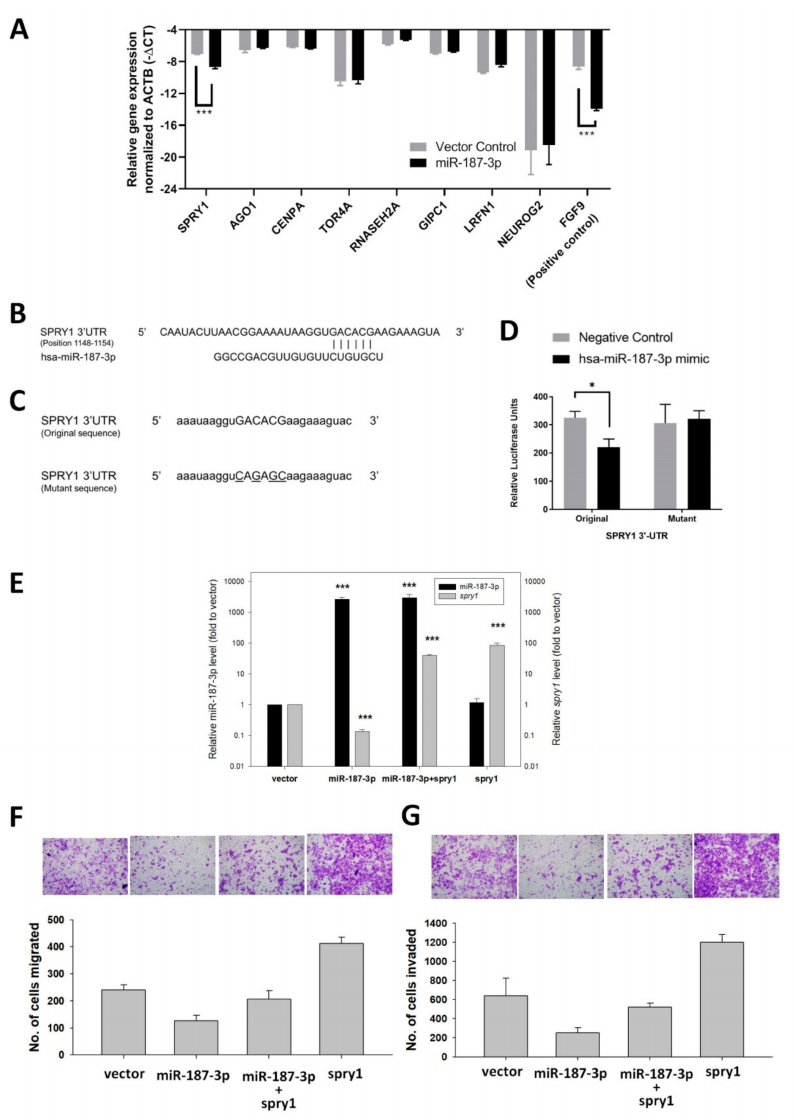
Figure 9. Identification of SPRY1 as a target gene of miR-187-3p in vitro: ( A ) Quantitative RT-PCR- based expression analysis of putative target genes within HCT116 stably transfected with miR-187-3p or the control vector. Expression of target genes was normalized to ACTB and reported as –delta Ct (negative delta Ct). FGF9 was used as a positive control. ( B ) Predicted binding site of miR-187-3p within the 3 (cid:48) -UTR region of the SPRY1 gene. ( C ) Design of SPRY1 (original and mutant) insert sequence within the reporter construct. Uppercase: potential binding site; underline: mutated bases within the potential binding site; lowercase: flanking 3 (cid:48) -UTR bases. ( D ) HCT116 cells were co-transfected with SPRY1 3 (cid:48) -UTR original or mutant sequence reporter constructs with has-miR- 187-3p mimic or negative control (empty vector) and Renilla luciferase control vector. The firefly luciferase signal for each transfectant was normalized by its corresponding Renilla luciferase signal and expressed in relative luciferase units. ( E ) Gene expression levels of miR-187-3p and SPRY1 within the HCT116 control vector cells (vector), stable miR-187-3p cells (miR-187-3p)), stable miR- 187-3p cells transiently transfected with the SPRY1 expression plasmid (miR-187-3p+SPRY1), or control vector cells transfected with the SPRY1 expression plasmid (SPRY1). ( F , G ) Rescue experiment demonstrating the effects of SPRY1 overexpression in HCT116 control vector cells or stable miR- 187-3p cells on ( F ) cell migration and ( G ) invasion. Data are expressed as the mean ± SEM of three independent experiments; * and *** indicate that the difference is statistically significant ( p < 0.05 and p < 0.001,